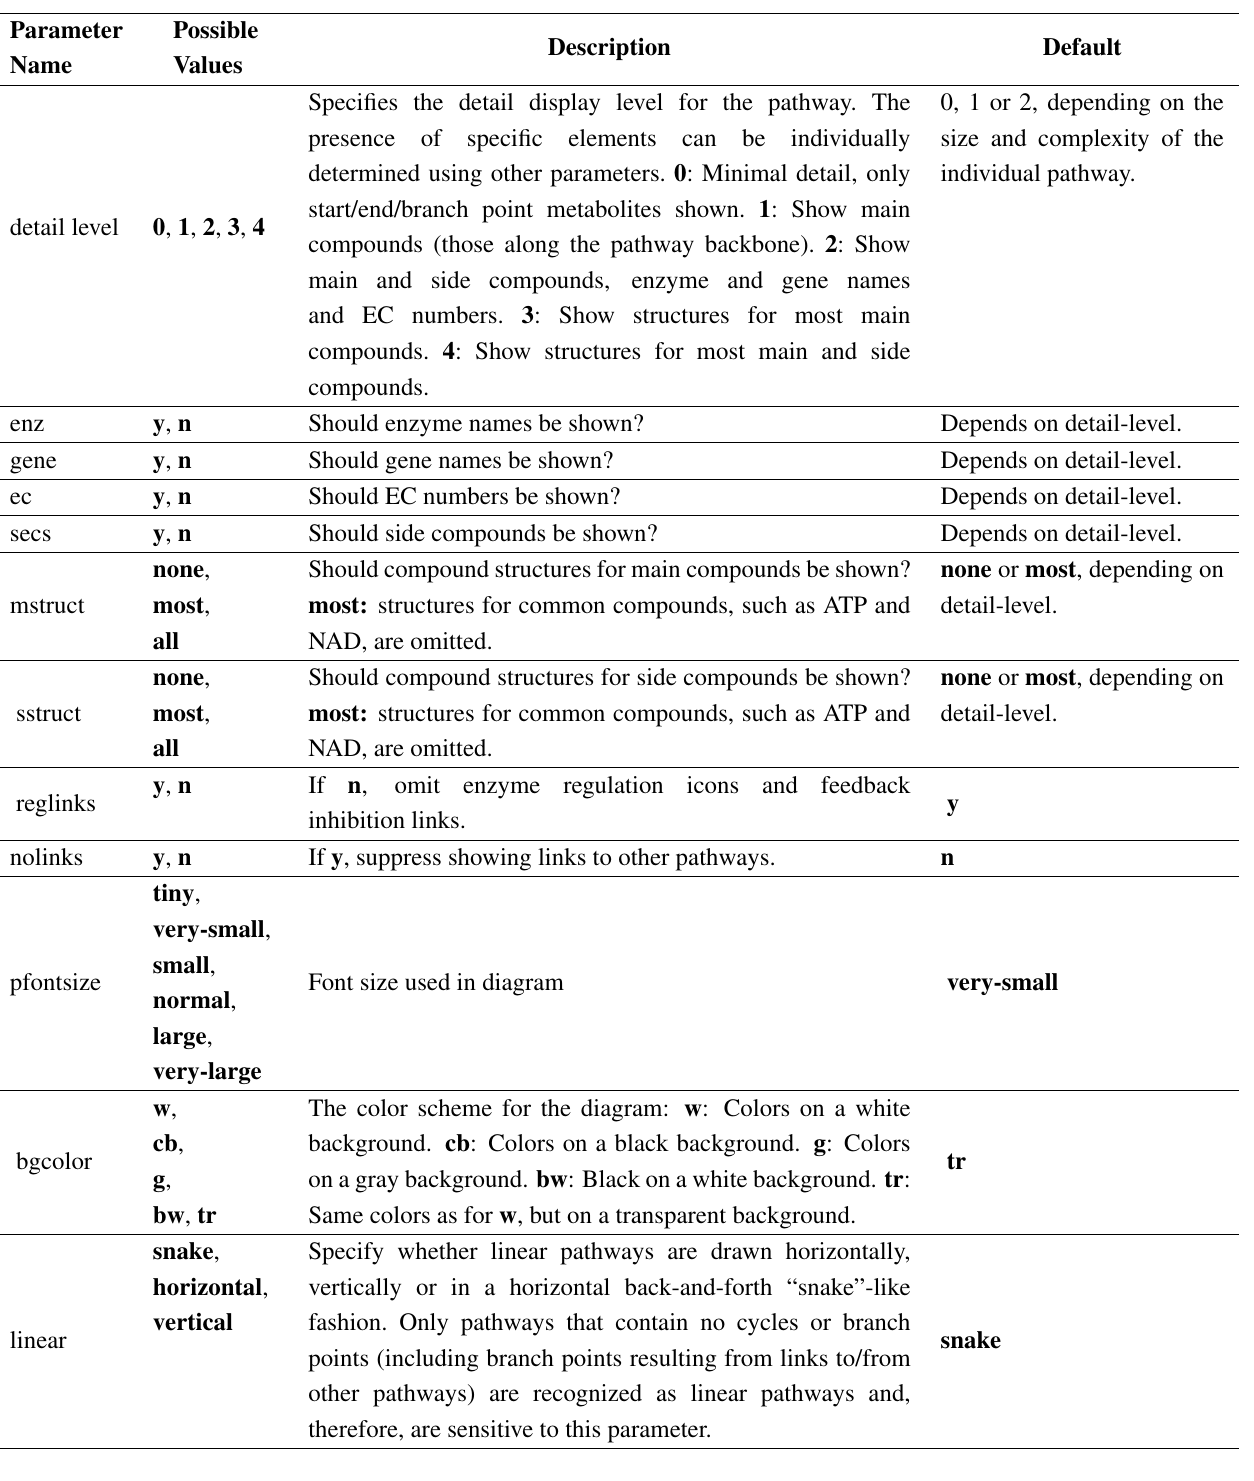
Table 3. Parameters to customize pathway